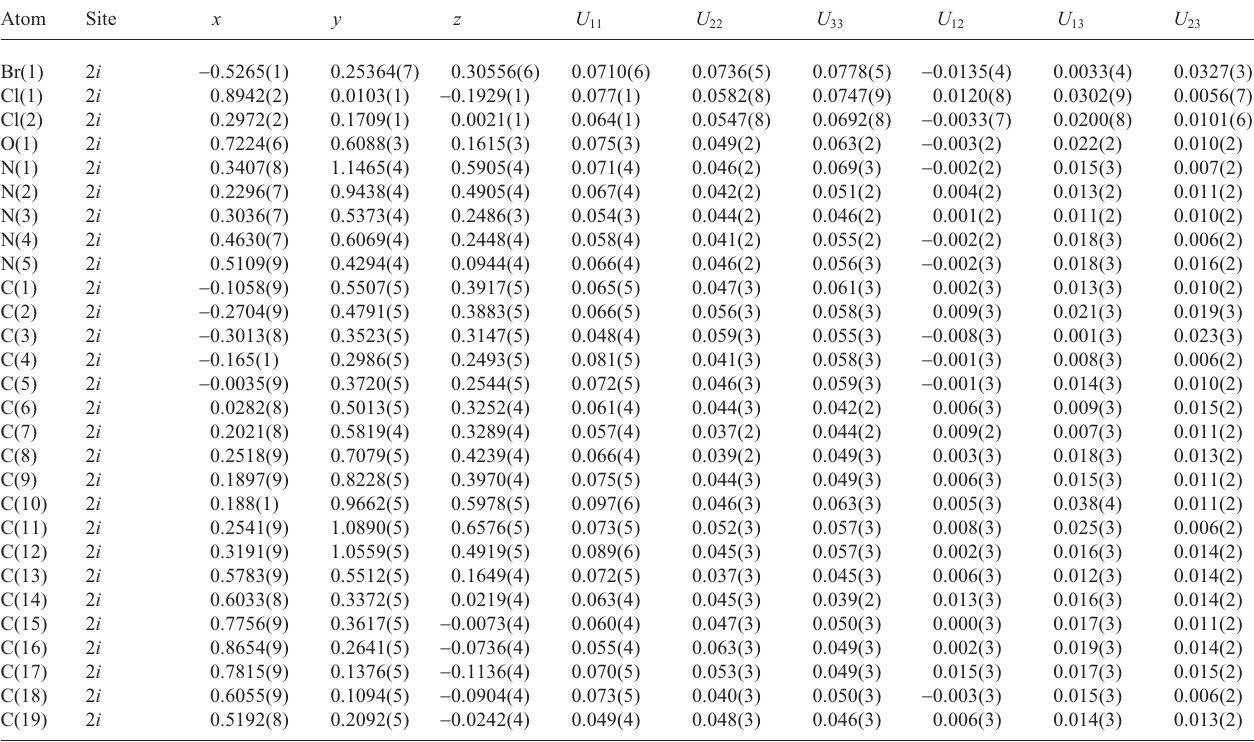
Table 3. Atomic coordinates and displacement parameters (in Å 2 )